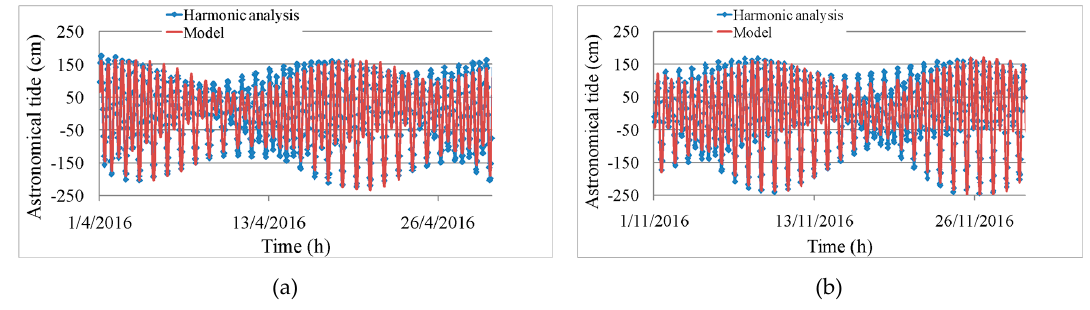
Figure 9. Comparison of tides predicted by ROMS 2D with harmonic analysis at Vung Tau in ( a ) April 2016 and ( b ) November 2016.